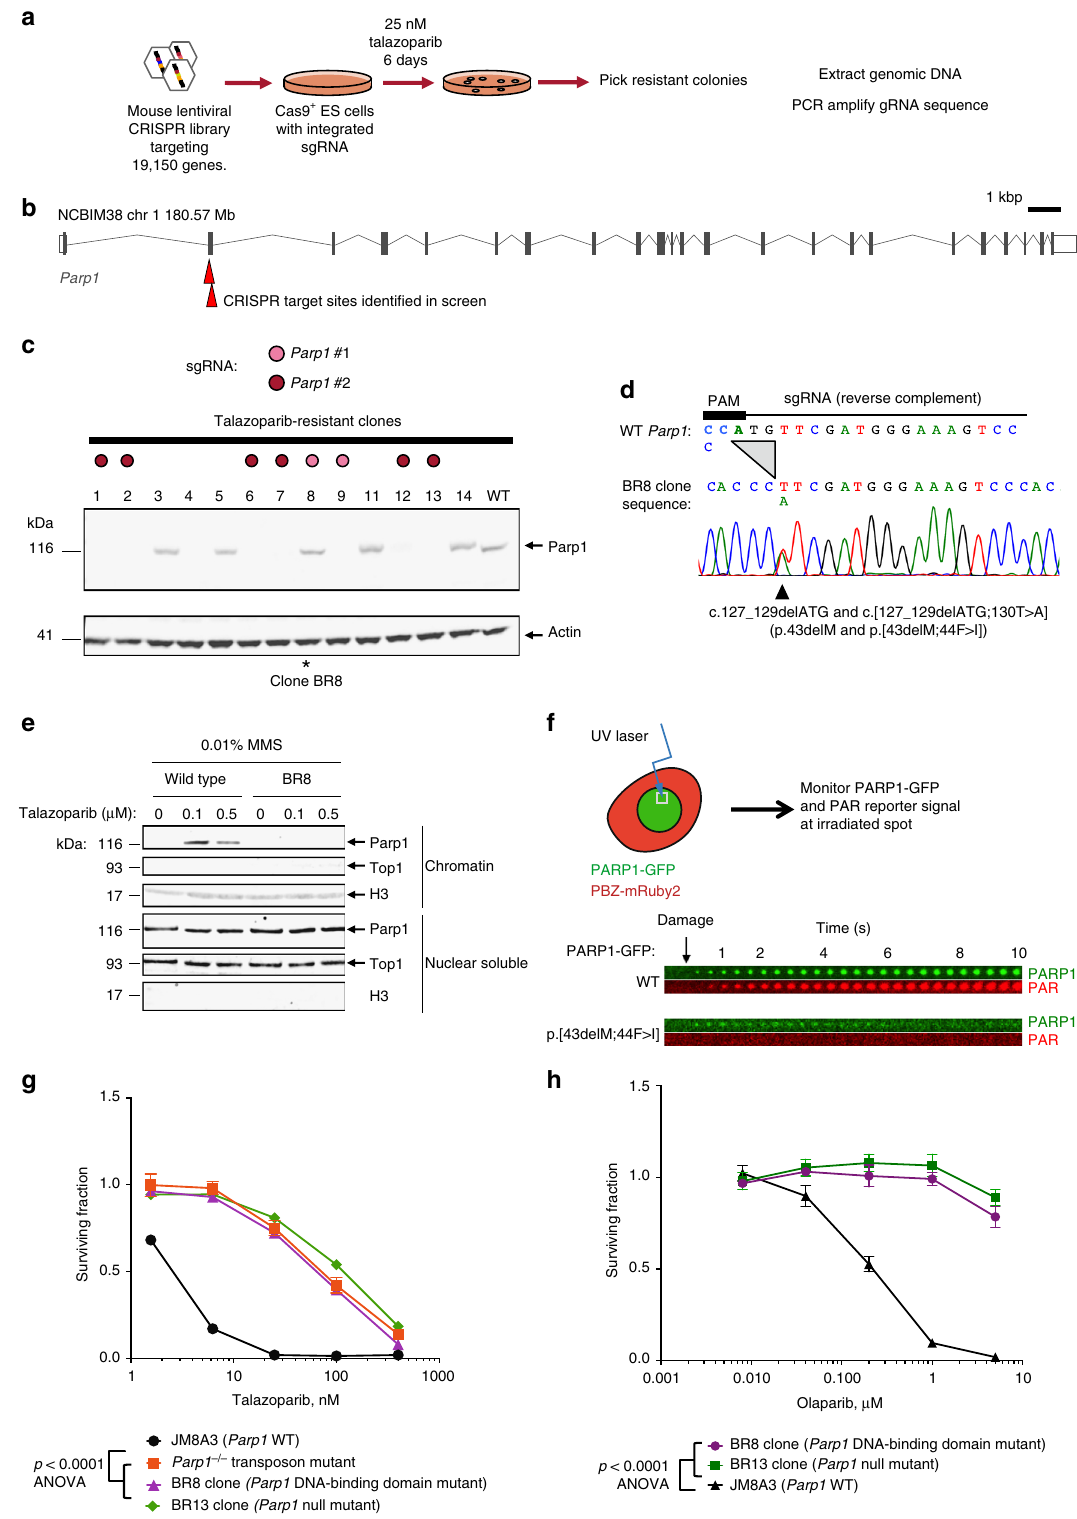
screen25 nM talazoparib 6 days